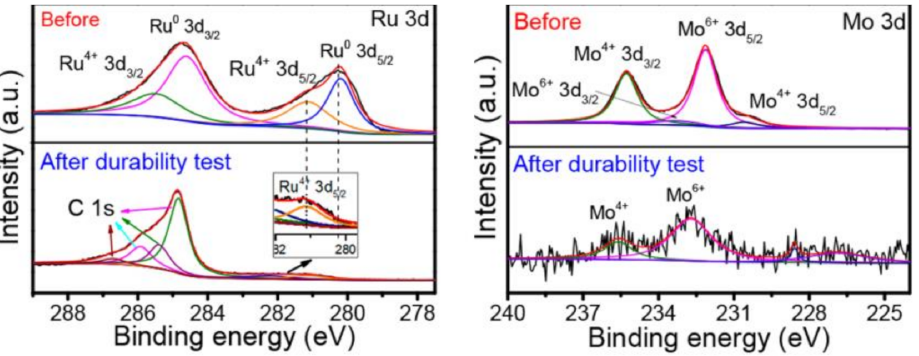
Figure 5. XPS spectra of Ru 3d and Mo 3d of the AlNiCoRuMo before and after durability test. Adapted with permission from [140]. Copyright © 2021, American Chemical